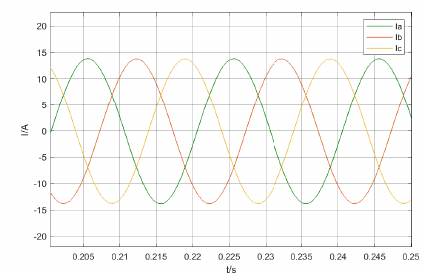
Figure 11. Steady-state current waveform when m = 0.6, D = 0.